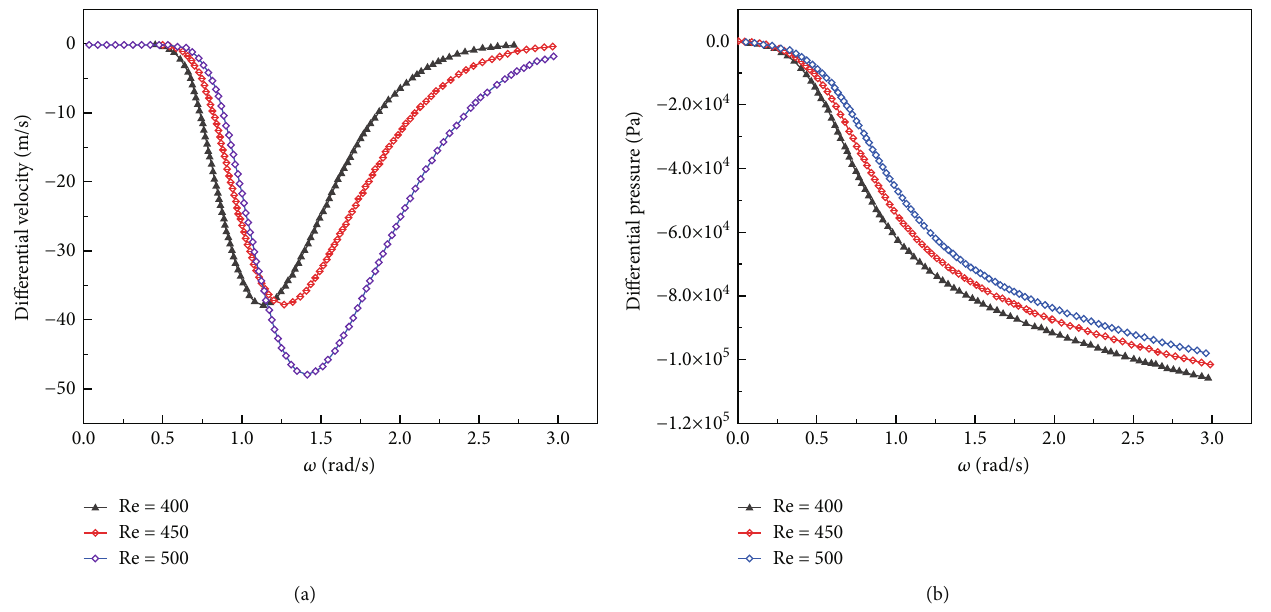
Figure 4: Distribution of the steady fl ow fi eld in the constant cross-section pipe at a certain time.